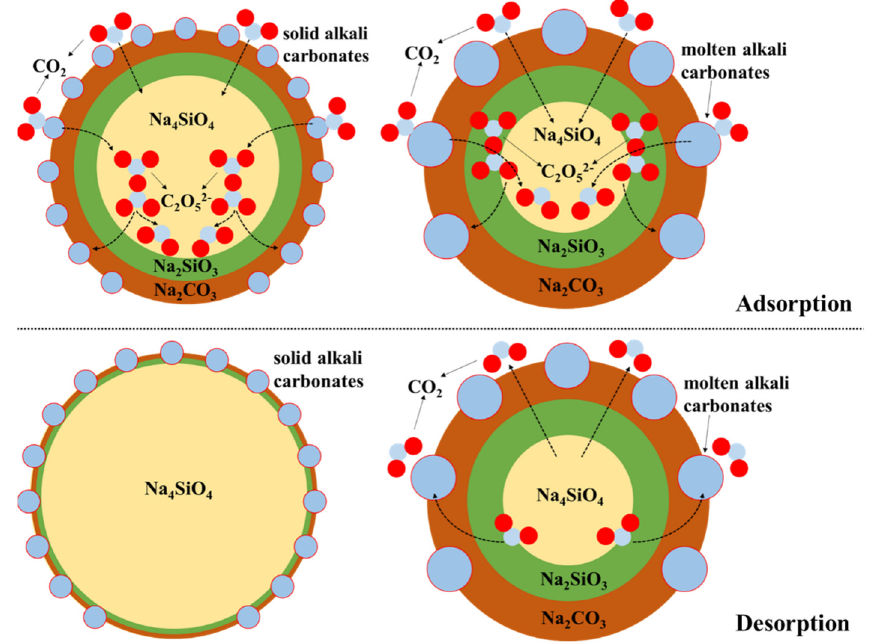
Figure 9. Schematic illustration of the CO 2 sorption and desorption pathway for the Na 4 SiO 4 mixed alkali carbonates.